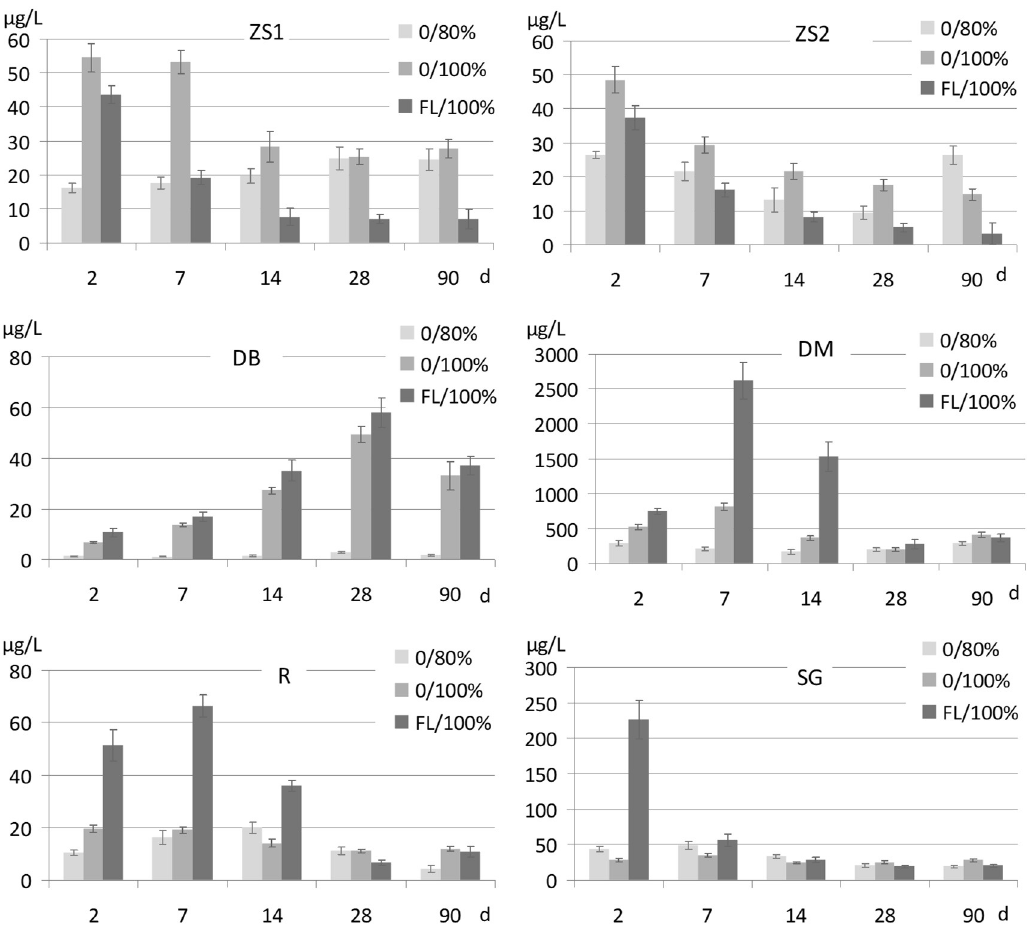
Figure 6. Sb concentrations in pore water of soils incubated at the moisture 100% of maximum water capacity without addition of forest litter (0/100%) and with beech forest litter (FL/100%), compared with the treatment 0/80%.